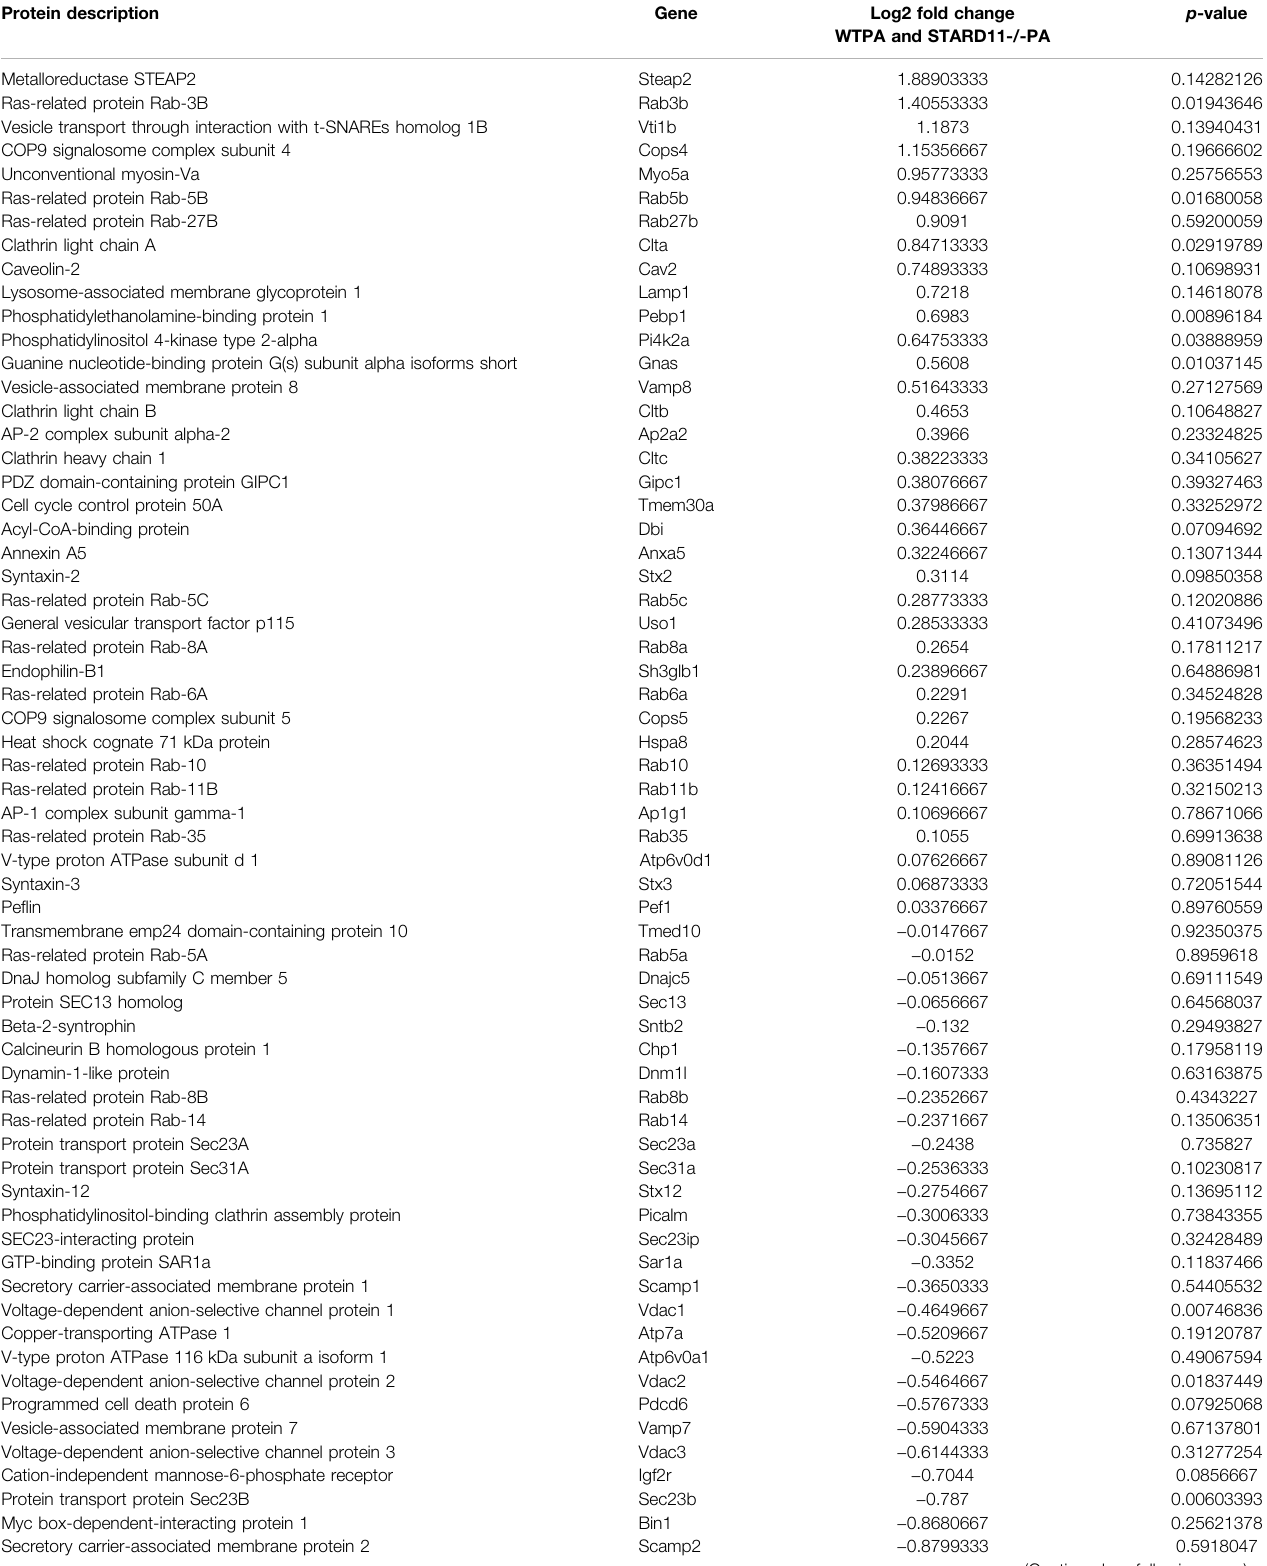
TABLE 4 | Traf fi cking proteins in palmitate stimulated EVs. Protein